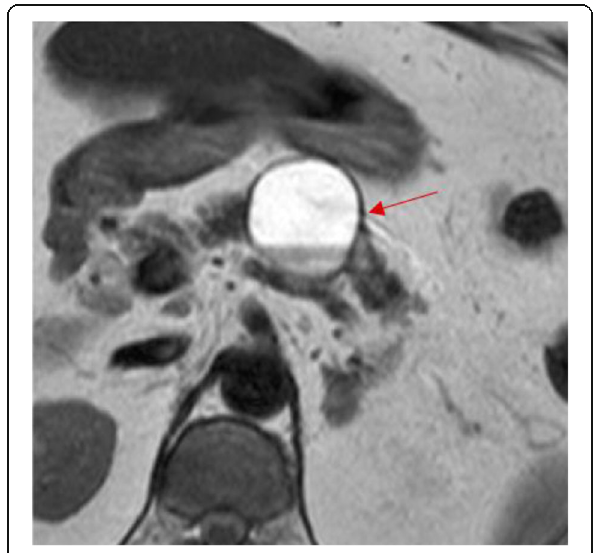
Fig. 4 Cytological examination demonstrated class IIIb adenocarcinoma